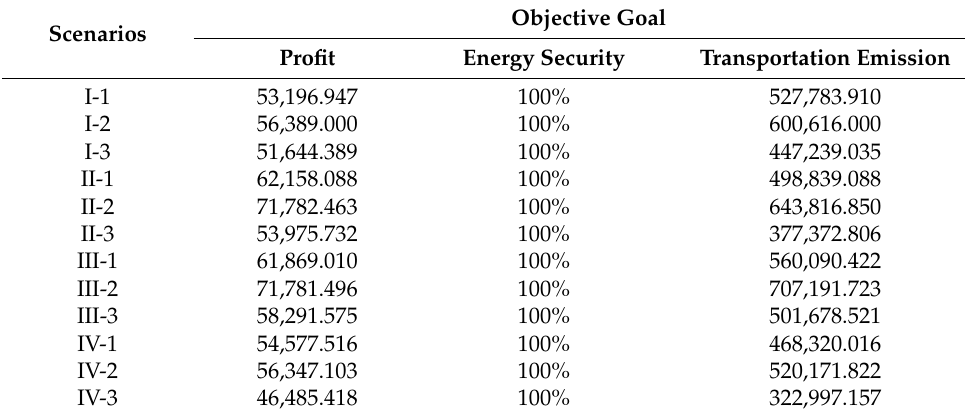
Table 8. Scenario